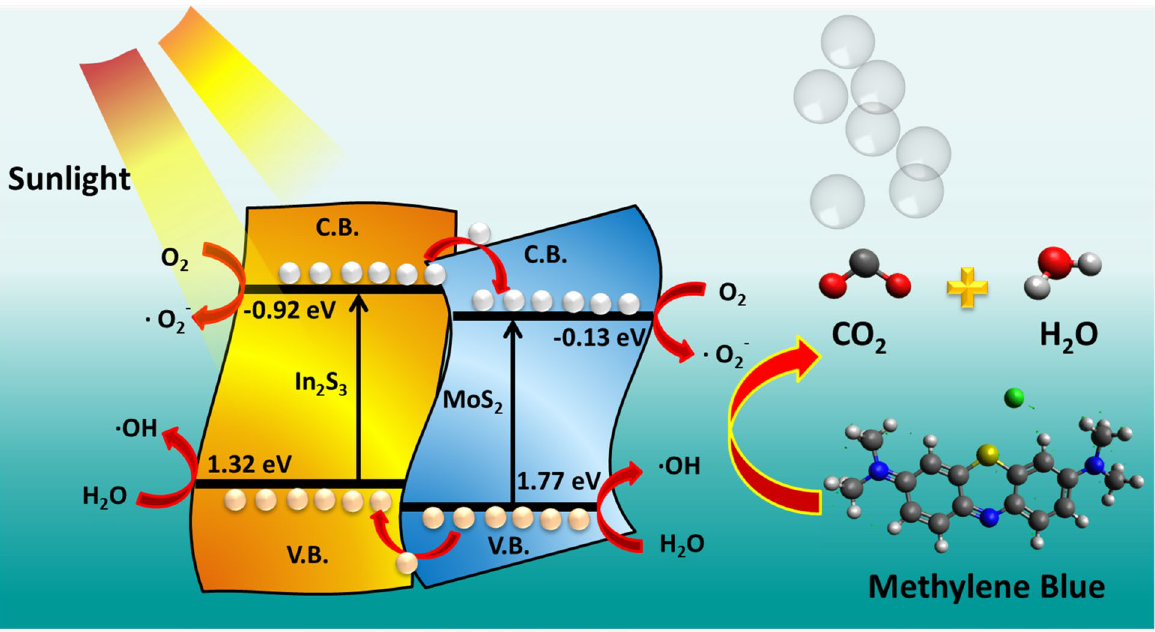
Figure 11. Energy level schematic diagram of In 2 S 3 –MoS 2 nanohybrids depicting the synergistic effect among